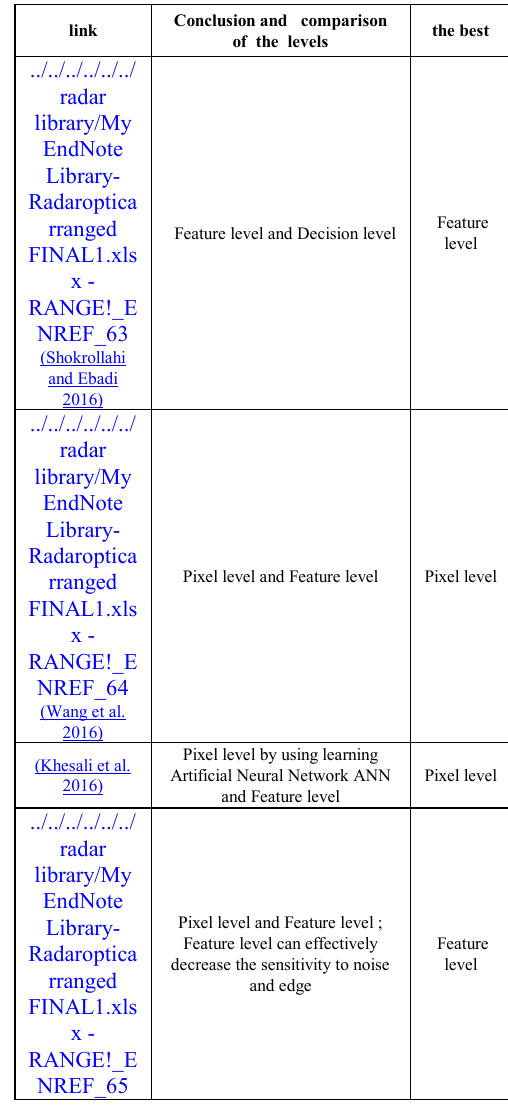
Table 5: Types of fusion